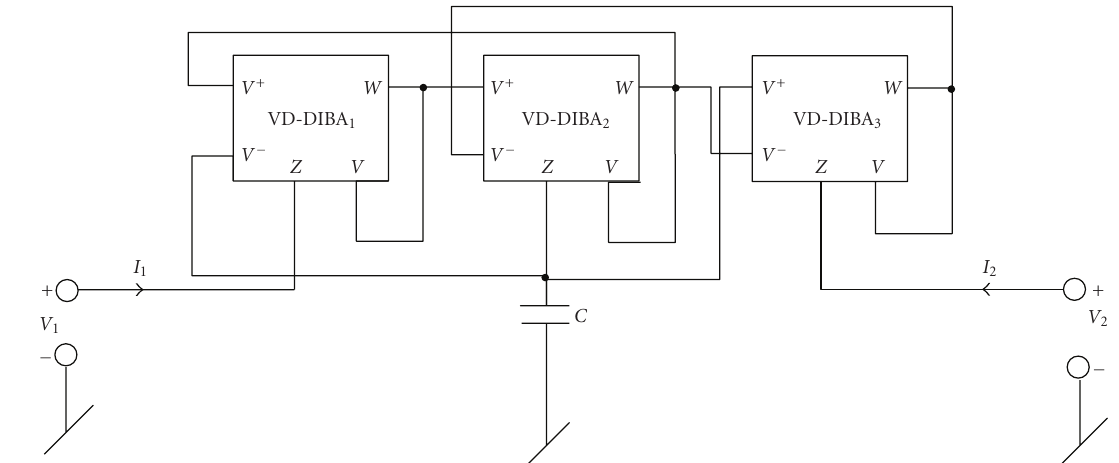
Figure 3: Proposed floating inductance simulation configuration.